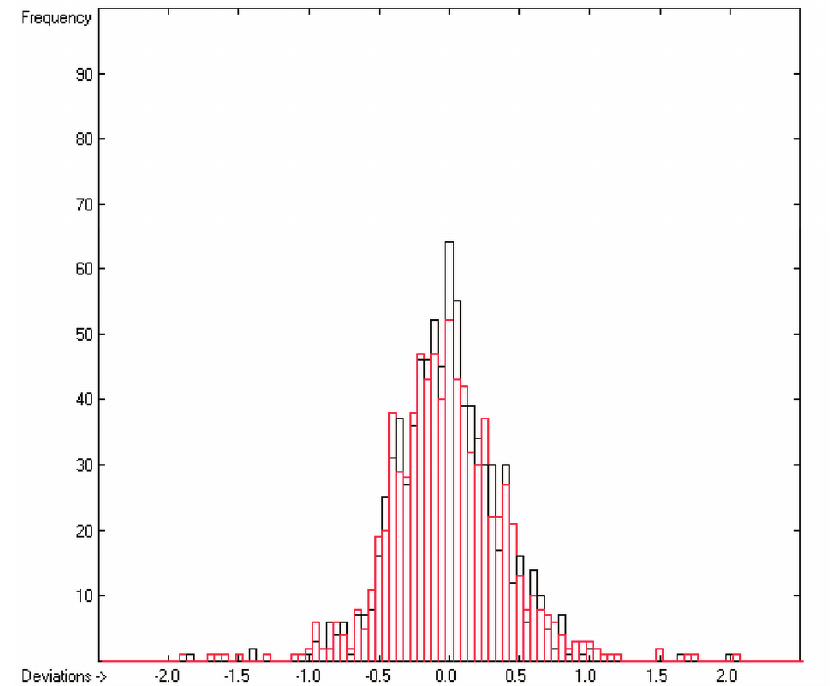
Figure 18. Histogram of toxicity data (S =